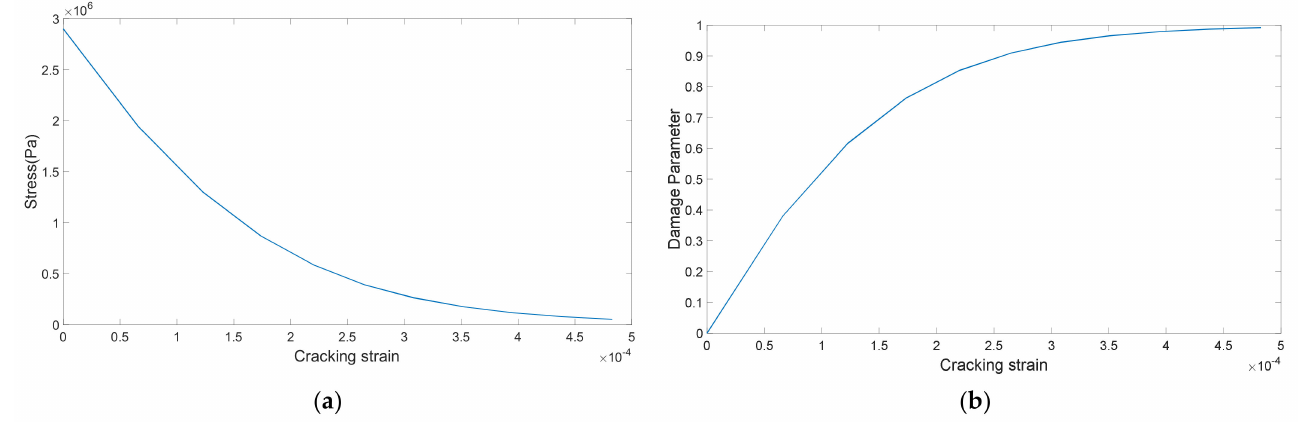
Figure 2. Inelastic tensile behavior of concrete: ( a ) tensile stress–strain curve; ( b ) tensile damage model.